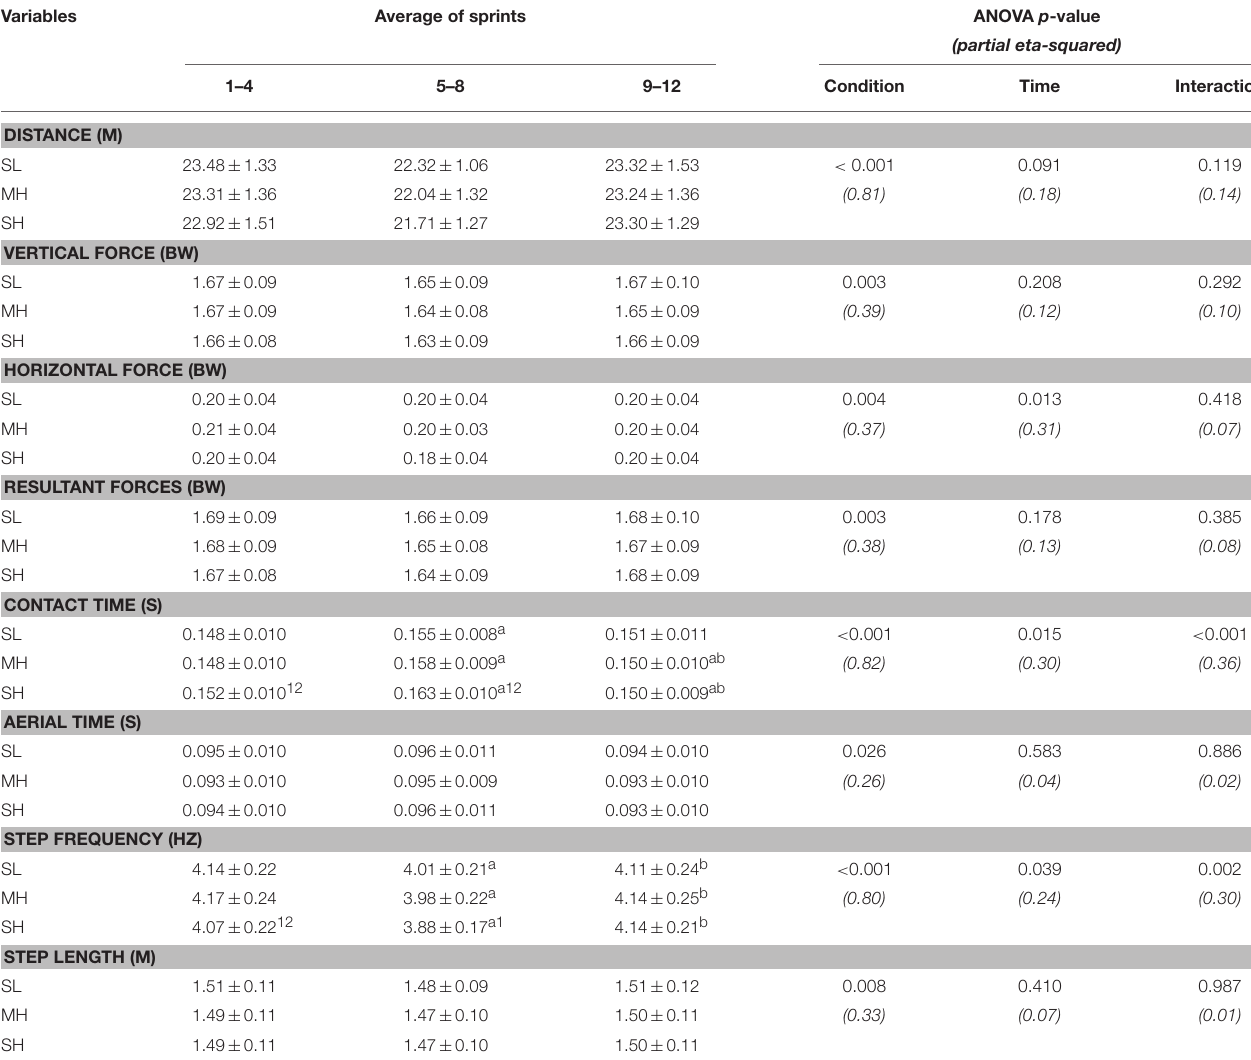
TABLE 1 | Sprint performance, kinetics, and kinematics averaged for sprints 1–4, 5–8, and